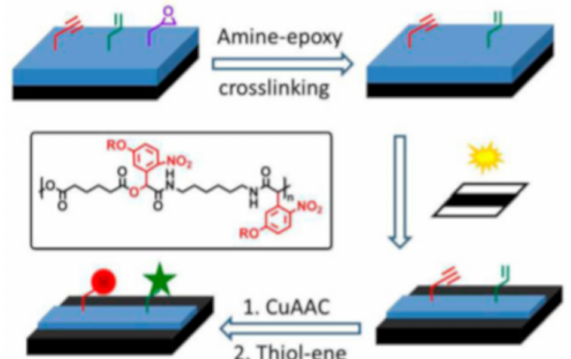
Figure 15. Schematic representation of the process for generation of multifunctional pattern on silicon wafer (Reprinted with the permission from reference [122] Copyright 2014 American Chemical